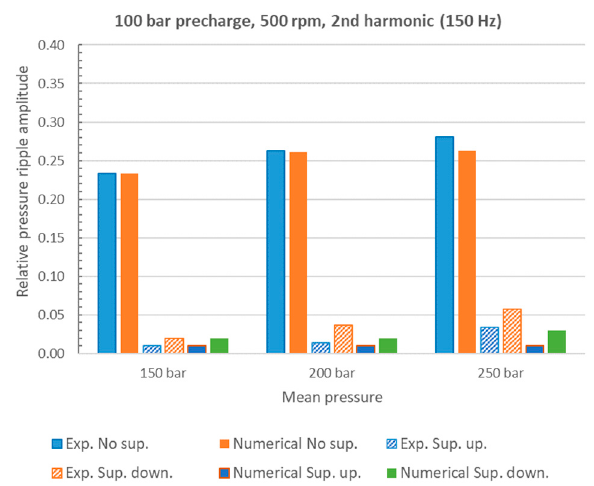
Figure 14. FFT of the pressure ripple, 2nd harmonic, pump speed = 500 rpm.